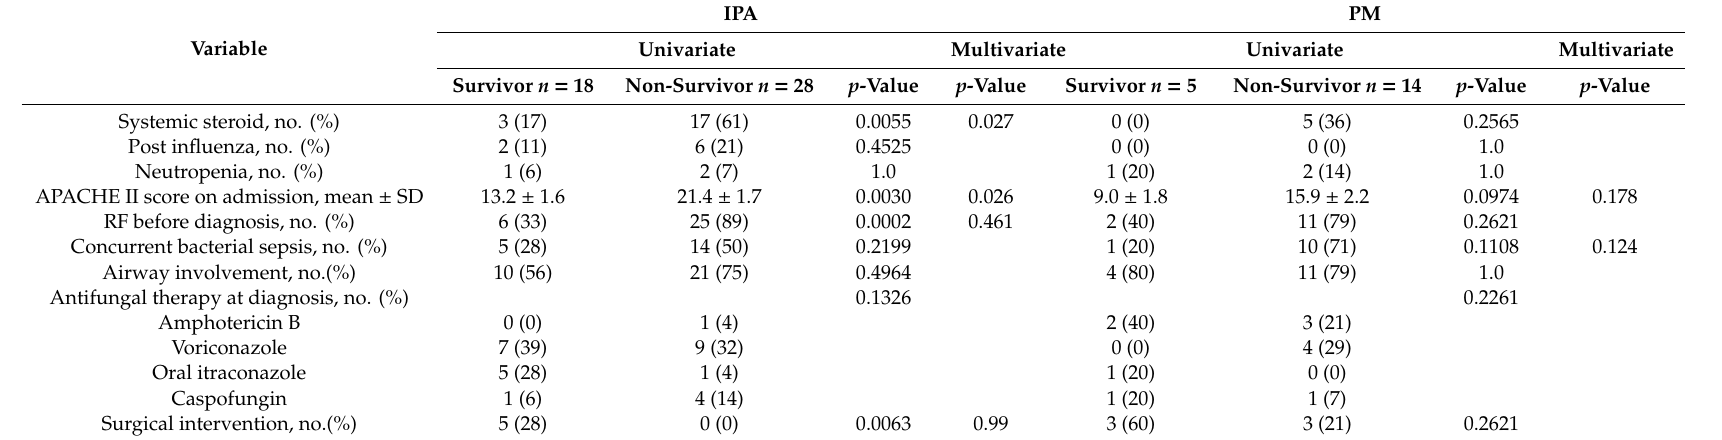
Table 2. Predicting factors for in-hospital mortality in IPA and